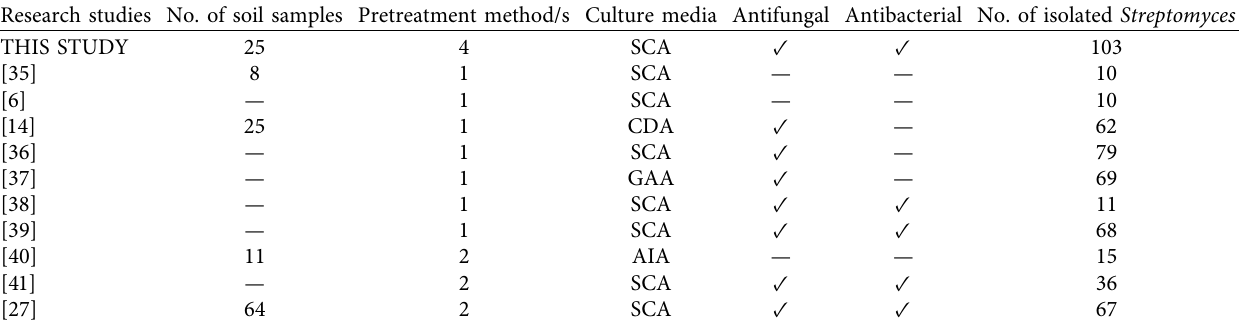
Table 3: The number of Streptomyces isolated in this study in comparison to previous